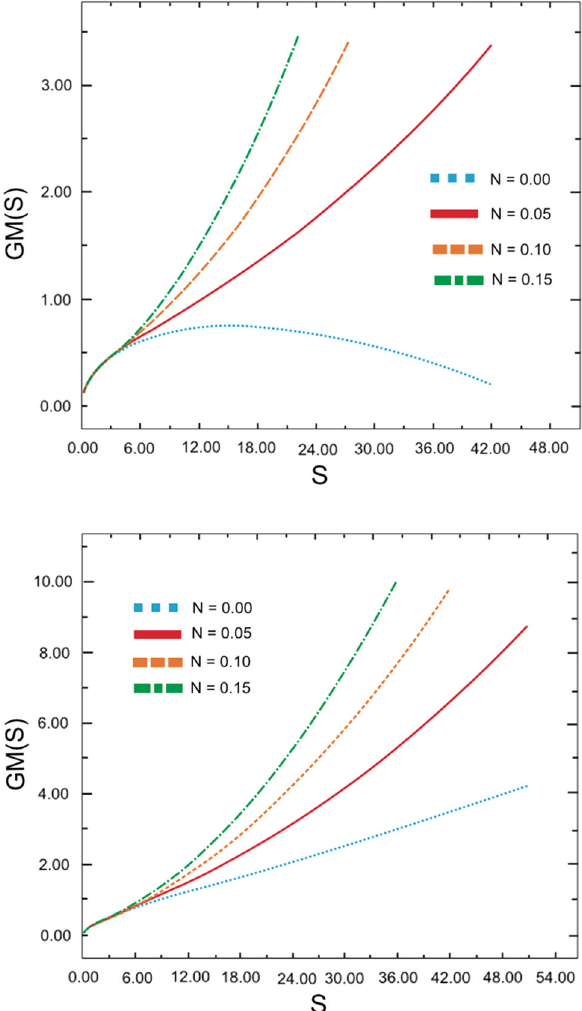
Fig. 1 Graphs for GM ( S ) × S . In the upper panel, (cid:15) > 0 is taken into account, while in the lower panel, (cid:15) < 0, with (cid:2) = 0 .